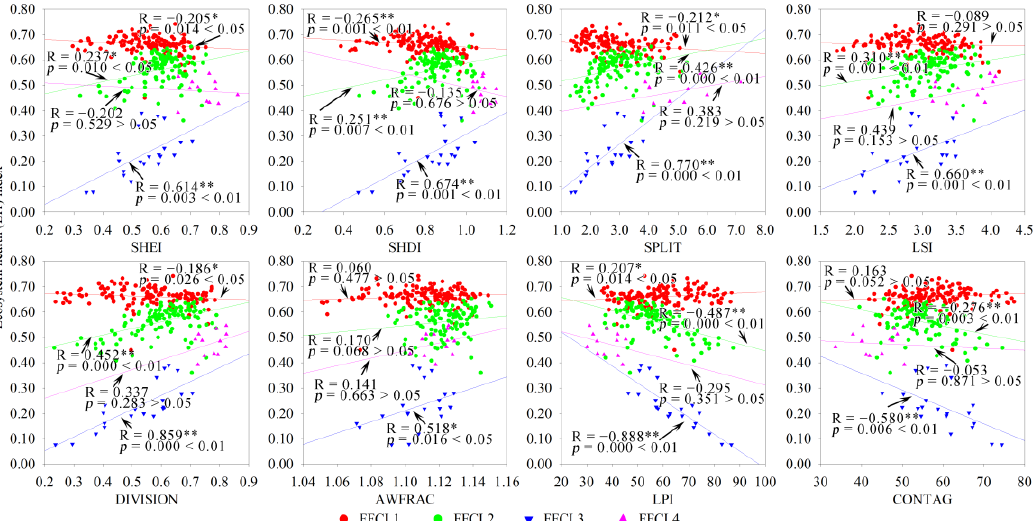
Figure 11. Correlation of landscape composition and configuration with ecosystem health in forestland + farmland + construction land mixed landscape. FFCL, forestland + farmland + construction land mixed landscape; SHEI, Shannon’s evenness index; SHDI, Shannon’s diversity index; SPLIT, splitting index; LSI, landscape shape index; DIVISION, landscape division index; AWFRAC, area- weighted mean fractal dimension index; LPI, largest patch index; CONTAG, contagion index. * p -values at 5% level; ** p -value at 1% level.